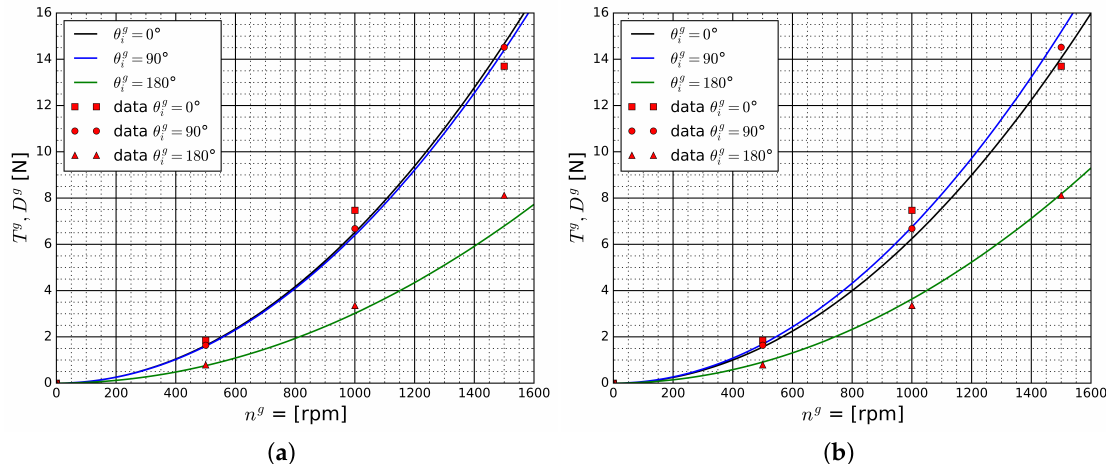
= 0°, 90°, and 180° and T m ( n ) = T nn n 2 , based on the Figure 9. Model fits for T g with θ g i